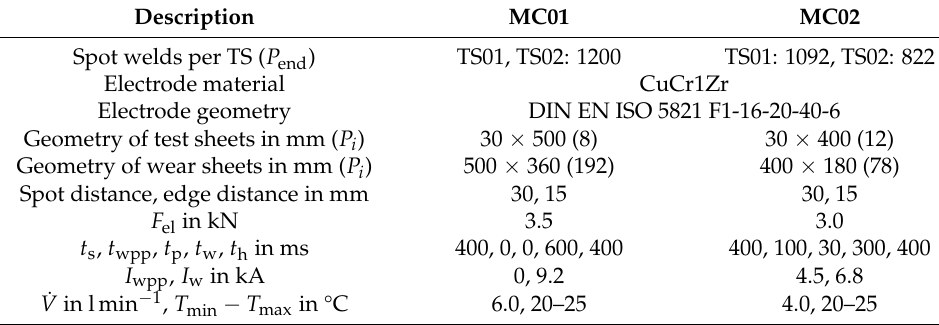
Table 2. Test setup for welding